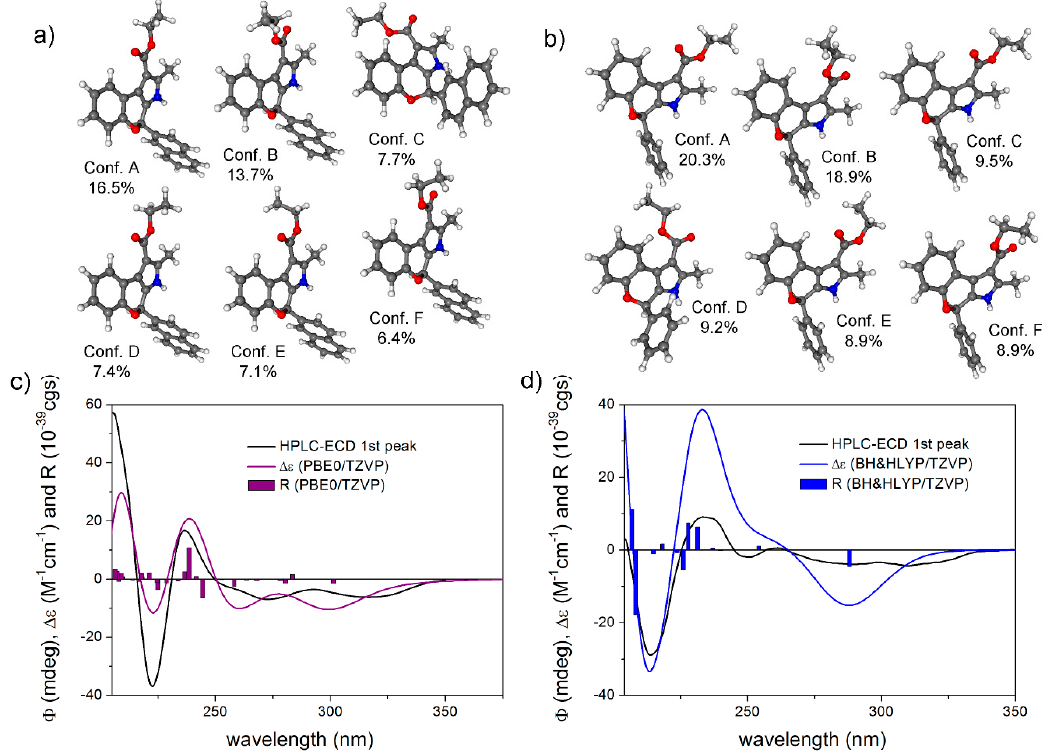
Figure 6. Structures and populations of ( a ) the six lowest energy ω B97X / TZVP PCM / CHCl 3 conformers of ( R )- 4g , ( b ) six lowest energy ω B97X / TZVP PCM / CHCl 3 conformers of ( R )- 4a . HPLC-ECD spectra of the first-eluting enantiomer (black line) of ( c ) 4g compared with the PBE0 / TZVP PCM / CHCl 3 // ω B97X / TZVP PCM / CHCl 3 spectrum of ( R )- 4g (purple line), ( d ) 4a compared with the PBE0 / TZVP PCM / CHCl 3 // ω B97X / TZVP PCM / CHCl 3 spectrum of ( R )- 4a (blue line). The bars represent rotational strength values for the lowest-energy solution conformer.